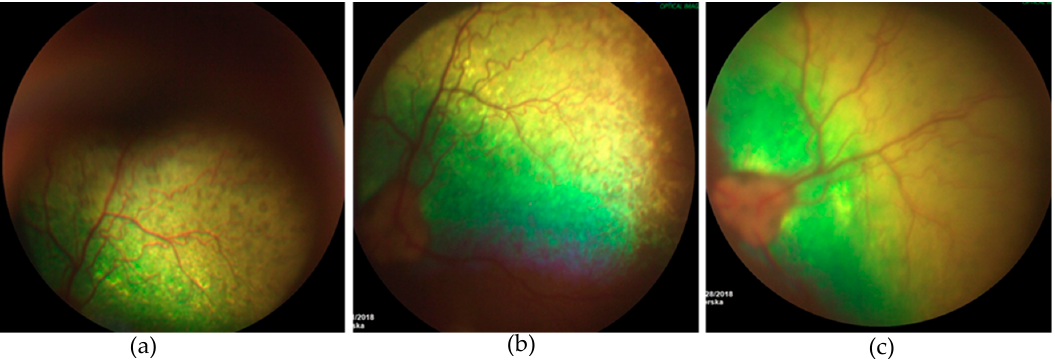
Figure 8. Fundus photographs before ( a ) and following hASC-MVs injection at one ( b ) and three-months ( c ). A noticeable decrease in tapetal pigmentation was observed, but areas of focal hyperreflectivity were noted nearer to the optic